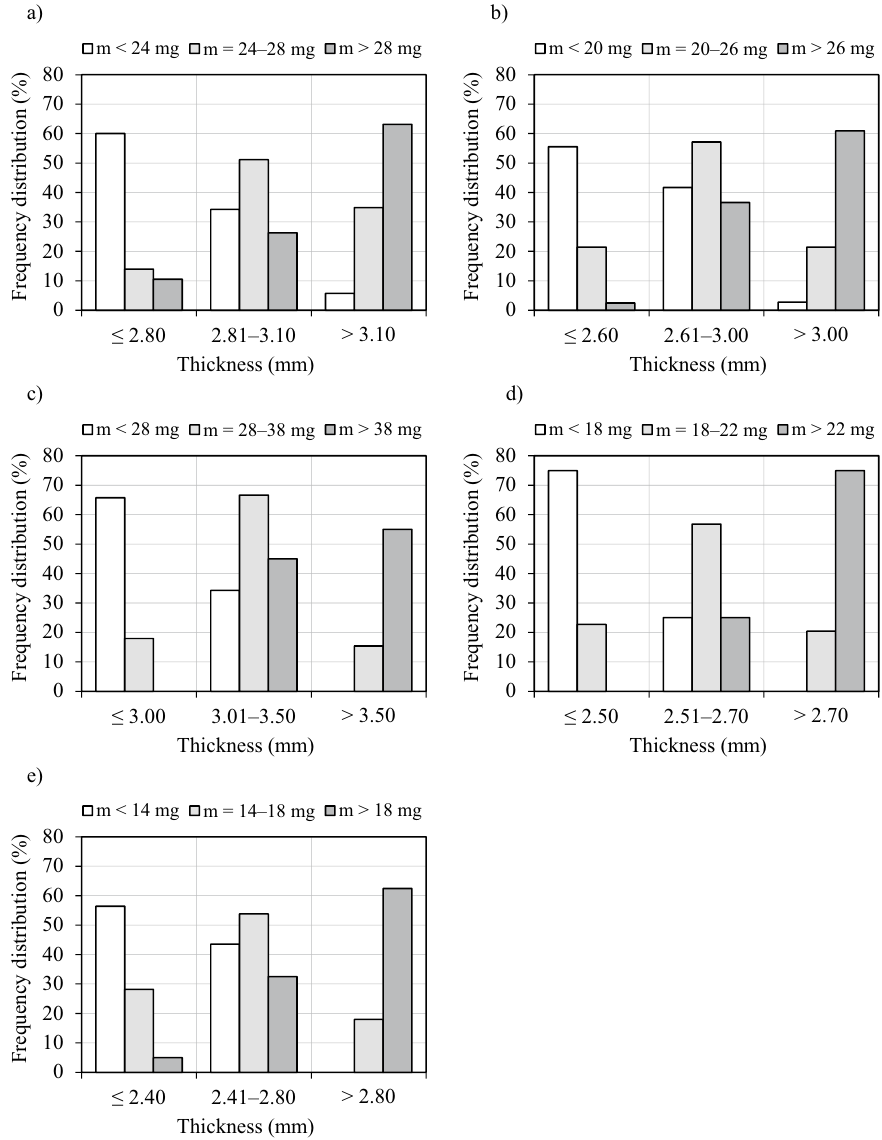
Figure 2. Distribution of seed thickness in spindle species: a) broadleaf, b) large-winged, c) European, d) Hamilton’s, e)